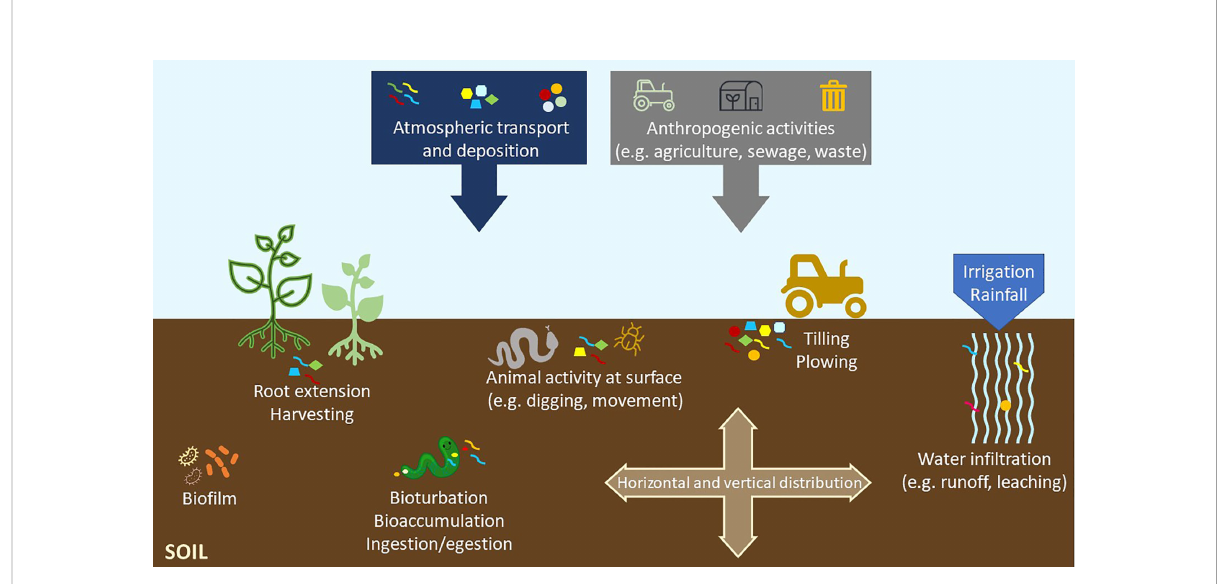
FIGURE 3 Sources of plastics in the terrestrial environment and factors that in fl uence their vertical and horizontal distribution in the